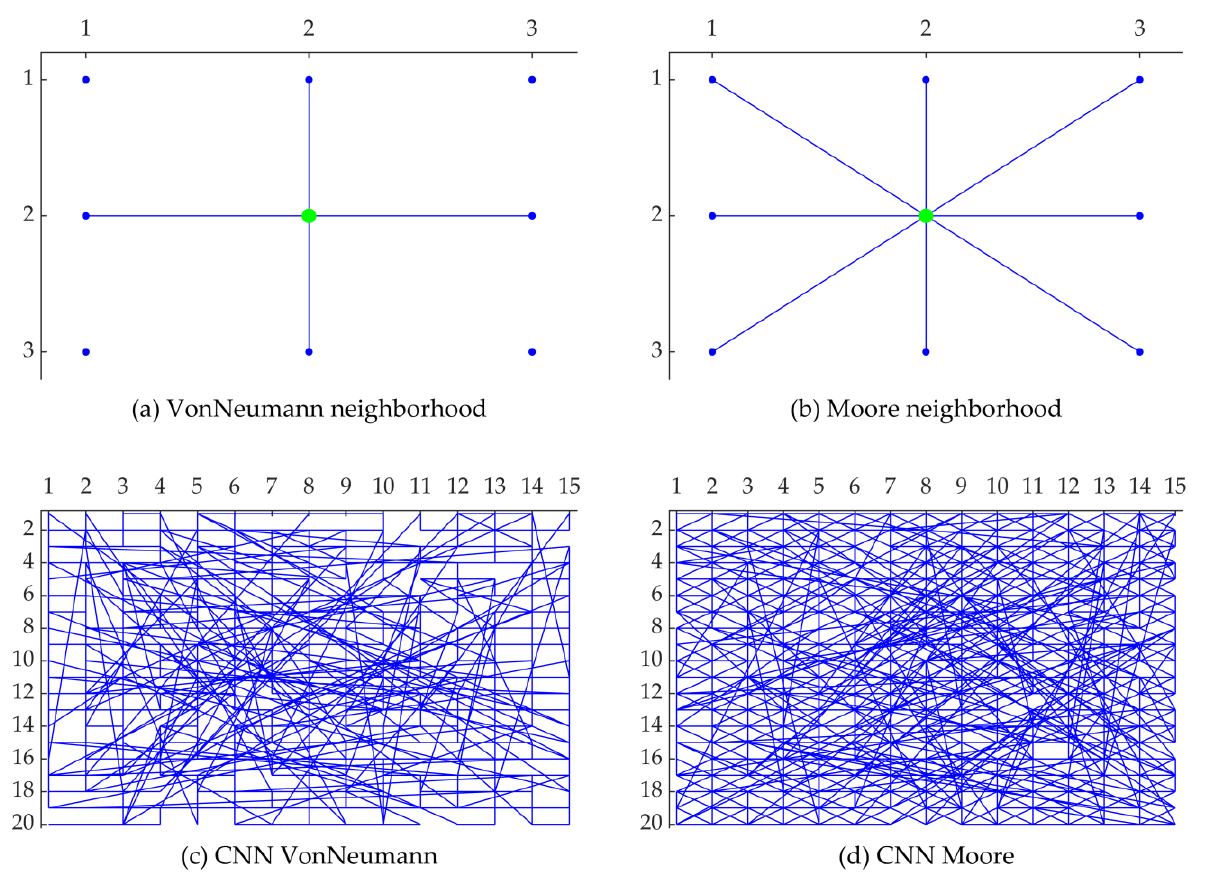
Figure 4. The instances of cellular neighborhood and cellular neighbor network. Algorithm 2 . The general pseudo-code for creating cellular neighbor network.